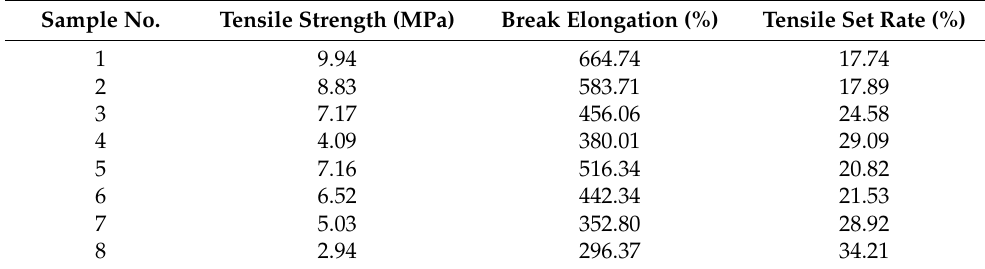
Table 5. Mechanical properties of samples